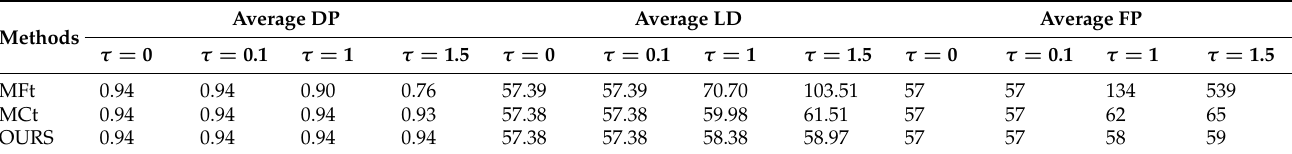
Table 3. Average results of DP , LD ( ‰ ) and FP of three methods under four different τ values 0, 0.1, 1 and 1.5. Average DP Average LD Average FP Methods τ = 0 τ = 0.1 τ = 1 τ = 1.5 MFt 0.94 0.94 0.94 0.94 0.94 0.93 0.94